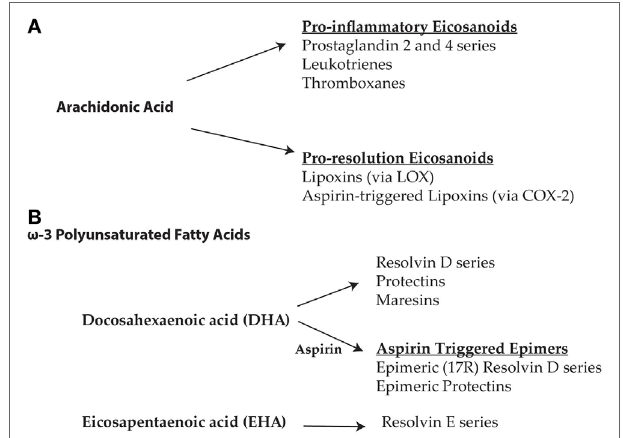
FigURe 1 | (A) The initiation phase of acute inflammation is characterized by an increase in the arachidonic acid-derived pro-inflammatory eicosanoids including prostaglandins, leukotrienes, and thromboxanes. Increases in prostaglandins eventually lead to a change in the biosynthesis of eicosanoids derived from arachidonic acid resulting in the formation of pro-resolution lipoxins via lipoxygenase-associated pathways. In the presence of aspirin, cyclooxygenase-2 is acetylated leading to the formation of the 15-epi-lipoxins (aspirin-triggered lipoxins). The aspirin-triggered isoforms are more resistant to degradation and hence more bioactive than native specialized pro-resolving mediators (SPMs). (B) Resolution is further propagated by the synthesis of SPMs derived from the omega-3 polyunsaturated fatty acids, docosahexaenoic acid (DHA), and eicosapentaenoic acid (EPA). SPMs derived from DHA include the resolvin D series, protectins, and maresins, as well as the aspirin-triggered epimeric (17R) forms of the resolvin D series and protectins. EPA derived SPMs include the resolvin E